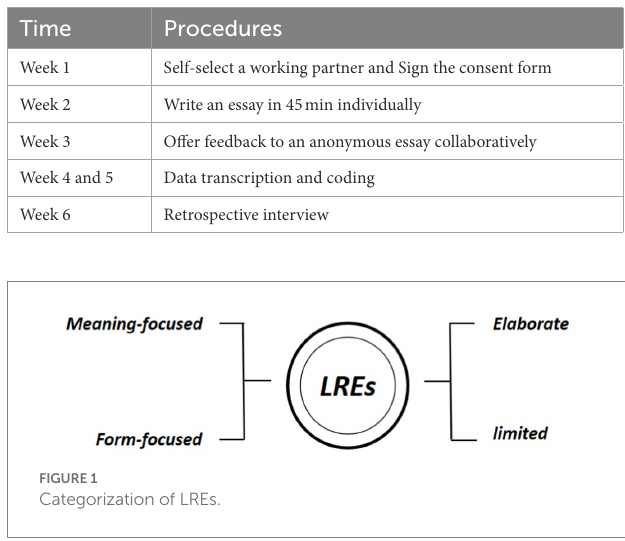
TABLE 1 Data collection procedure.